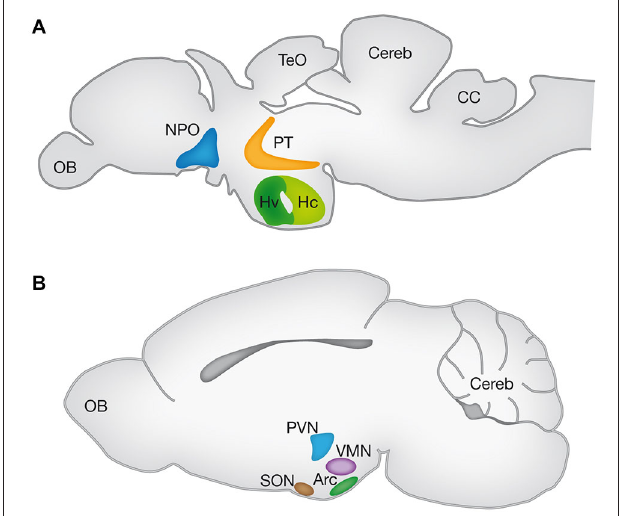
FIGURE 1 | Hypothalamic nuclei in vertebrates . Schematic lateral view of the zebrafish (A) and mouse (B) brains representing the projected 2D anatomy of multiple sagittal planes. Color matched areas represents the presumed homology between specific hypothalamic areas of zebrafish and mouse (see text). Arc, arcuate nucleus; CC, crista cerebellaris; CCe, corpus cerebelli; Hv: ventral zone of periventricular hypothalamus; Hc, caudal zone of periventricular hypothalamus; NPO, neurosecretory preoptic area; OB, olfactory bulb; PT, posterior tuberculum; PVN, paraventricular nucleus; SON, supraoptic nucleus; TeO, tectum opticum; VMN, ventromedial